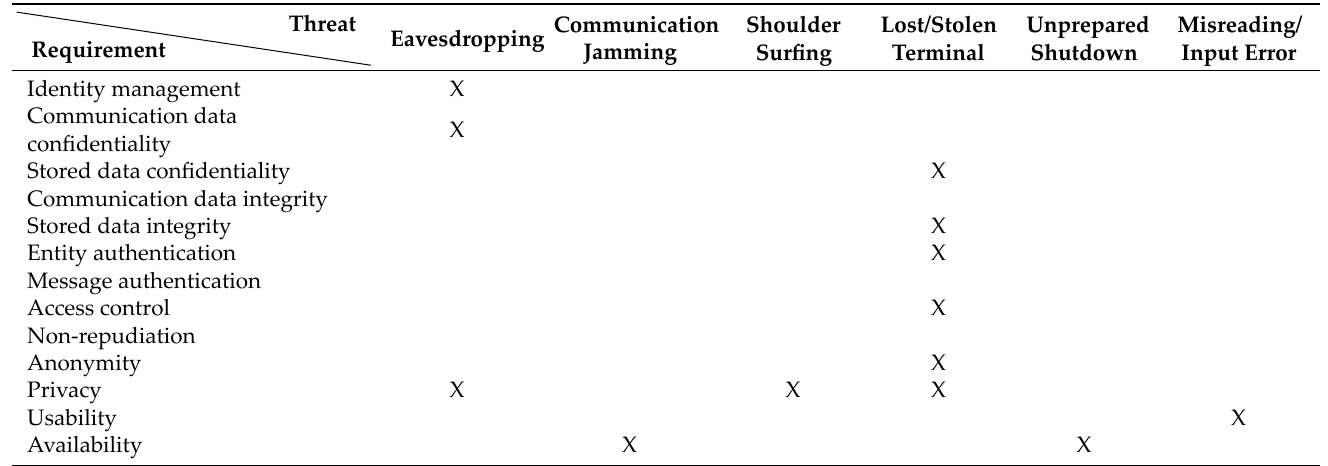
Table 3. Security threats and requirements in ITU‑T